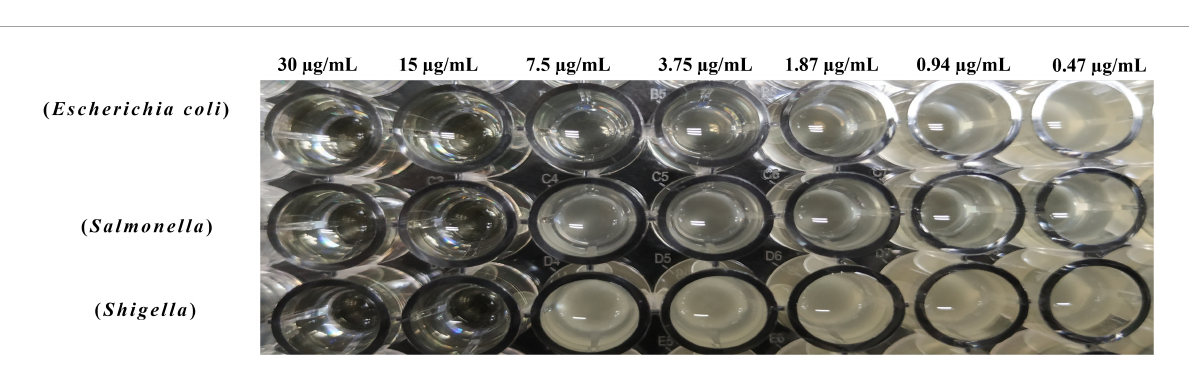
FIGURE6 Determination of the minimum inhibitory concentration (MIC) of BVYA1 to indicator bacteria by the double dilution method.